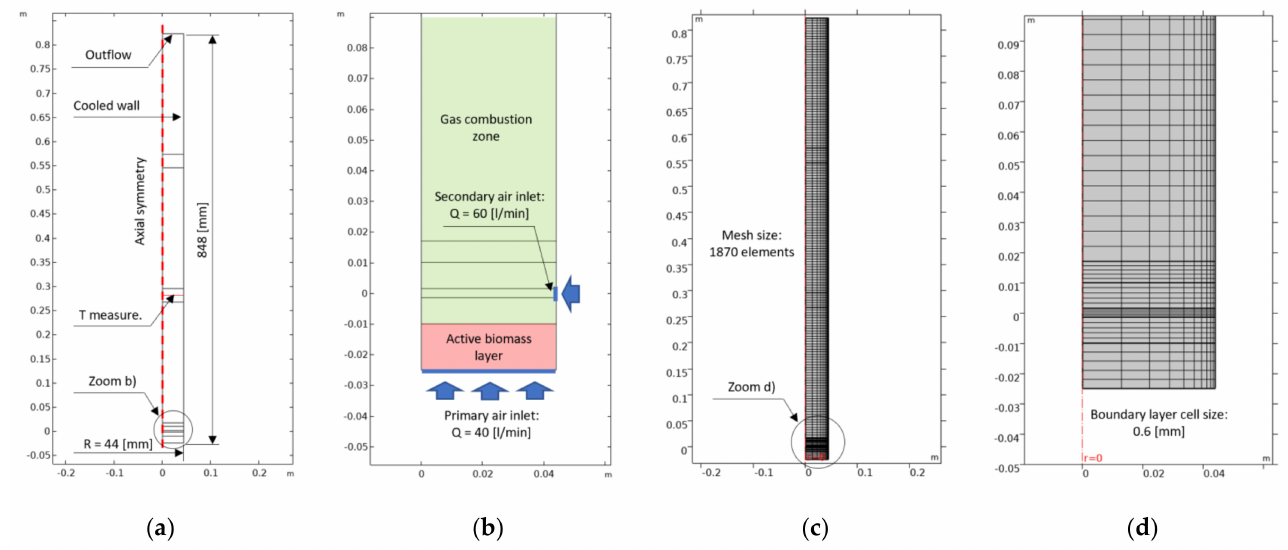
Figure 7. Model geometry ( a , b ) and mesh ( c ) used in numerical study ( d